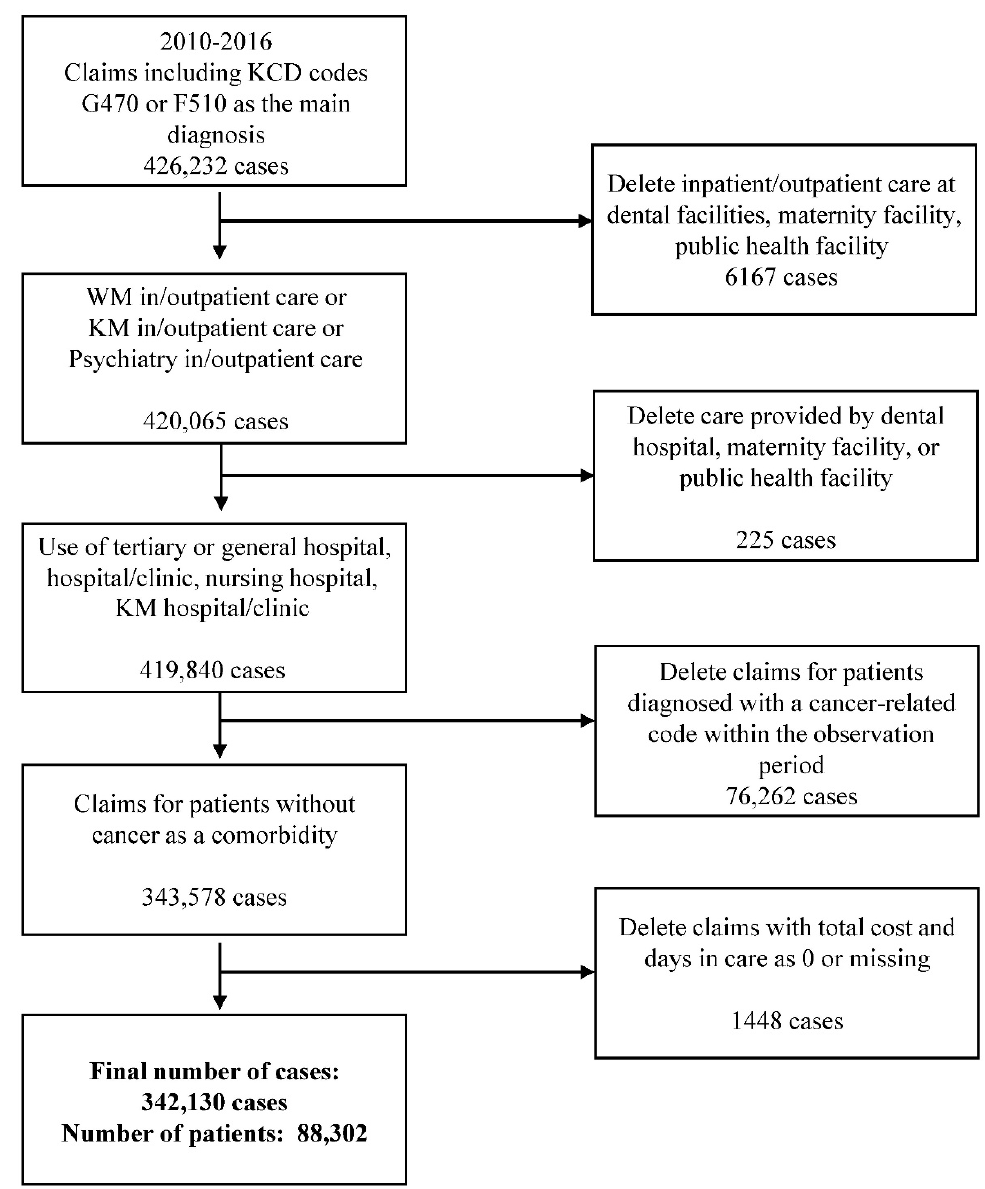
Figure 1. Flowchart of the study sample. KCD = Korean Standard Classification of Diseases; WM = Western medicine; KM = Korean medicine.